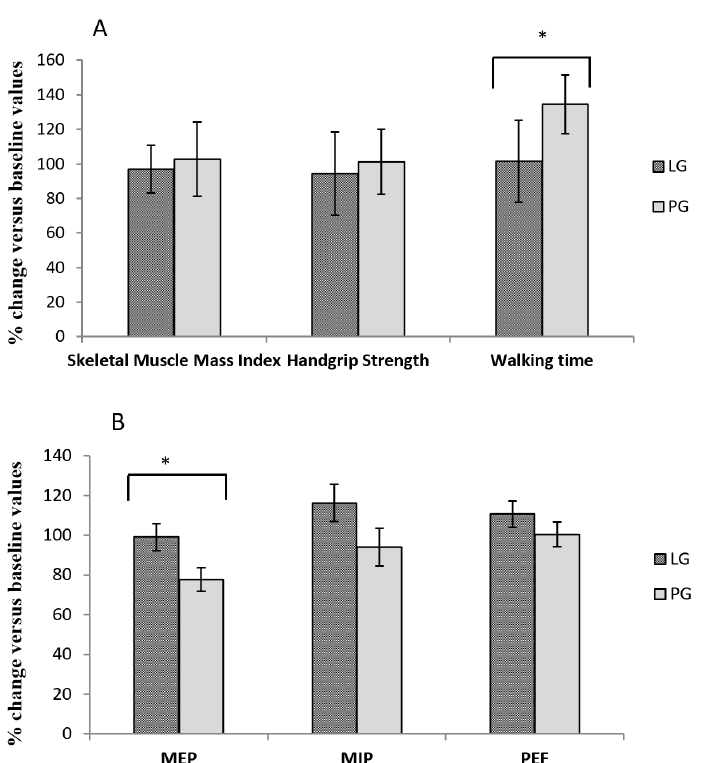
Figure 2. Effect of Leucine administration on sarcopenia criteria ( A ) and muscle respiratory sarcopenia ( B ). ( A ) Comparison of percentage changes compared to baseline values after leucine or placebo treatment for muscle mass index, handgrip strength and walking time * p = 0.011. ( B ) Comparison of percentage changes compared to baseline values after leucine or placebo treatment for respiratory muscle function * p = 0.026. Leucine group (LG); placebo group (PG); maximum static inspiratory (MIP) and expiratory (MEP) respiratory pressures at the mouth; peak expiratory flow